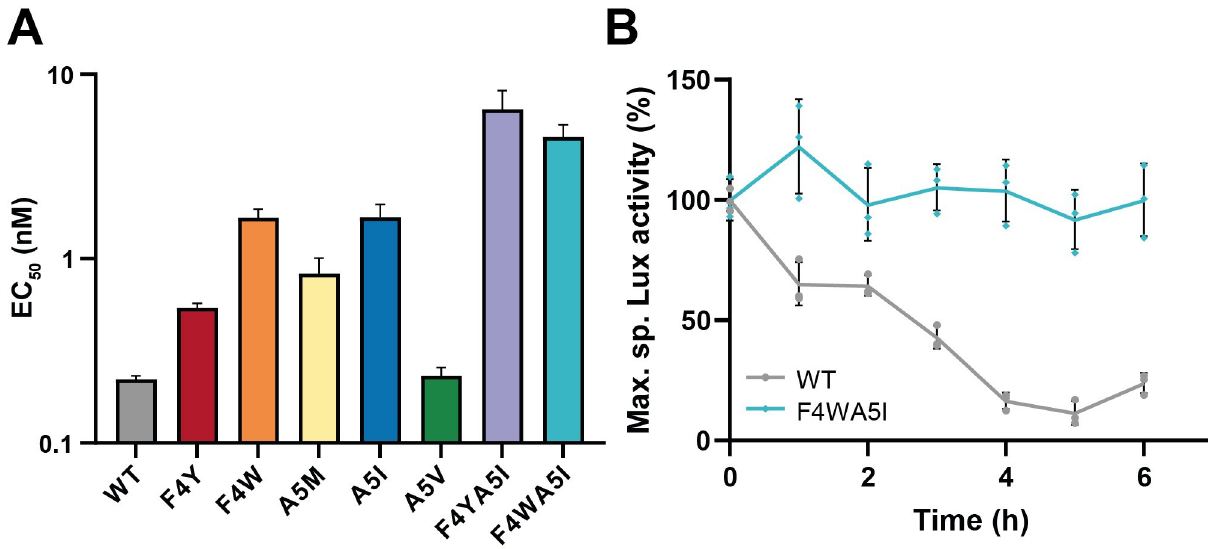
Fig 5. Degradation of PepF-resistant sXIP peptides. (A) PepF degradation efficiency for XIP (LPY[F/Y/W][A/M/I/V]GCL) variants. PepF was incubated 4 hours at 37˚C at various concentration with XIP variants (500 nM) and EC 50 was determined (S4 Fig). Bars denote standard deviations on the EC 50 computation. (B) XIP and XIP F4WA5I kinetics of degradation by PepF. PepF (8 nM) and the peptides (500 nM) were incubated 6 hours at 37˚C and sampled every hour for analysis. Reaction was stopped by adding 1 mM EDTA and further added to the P previously described. Dots show technical triplicates, the line connects mean values with error bars (standard